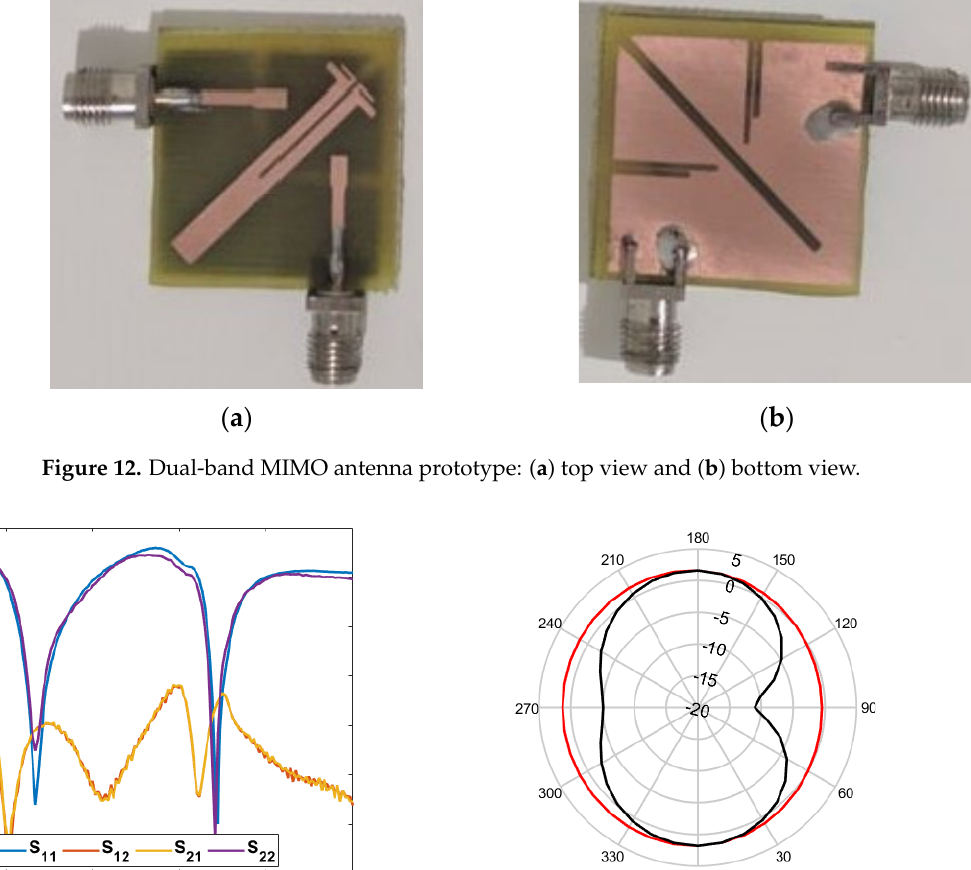
Figure 11. Simulated S-parameters results of the proposed dual-band MIMO antenna.